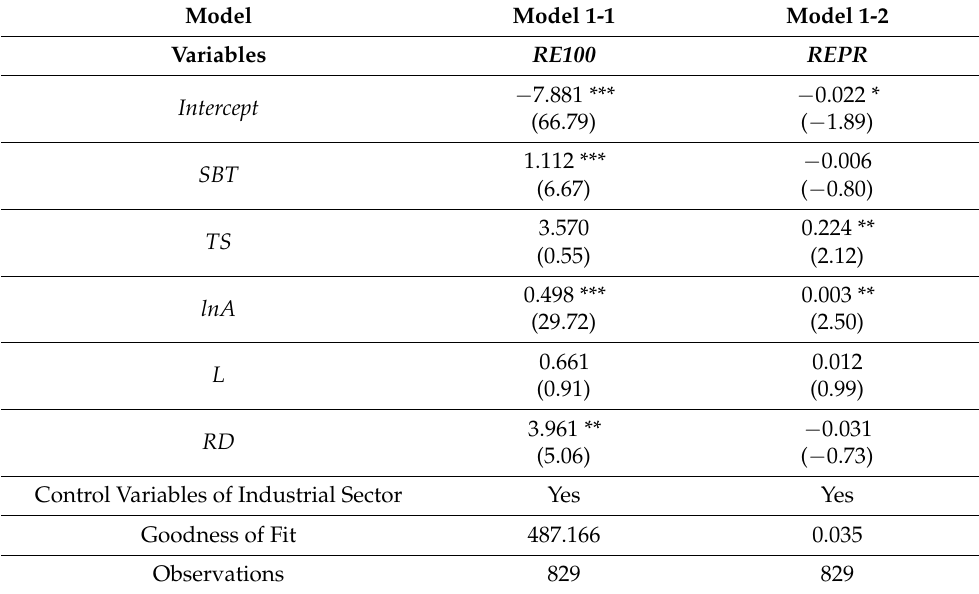
Table 2. The results for parameter estimates in Stage